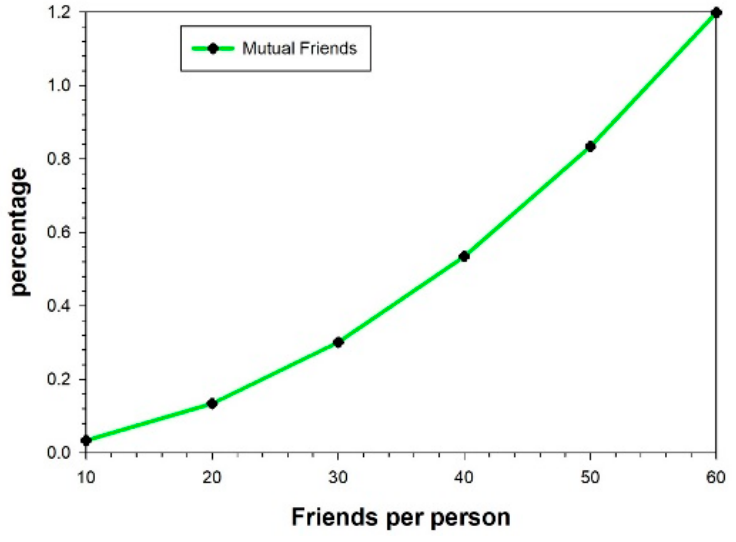
Figure 6. The mutual friends per person (devices).